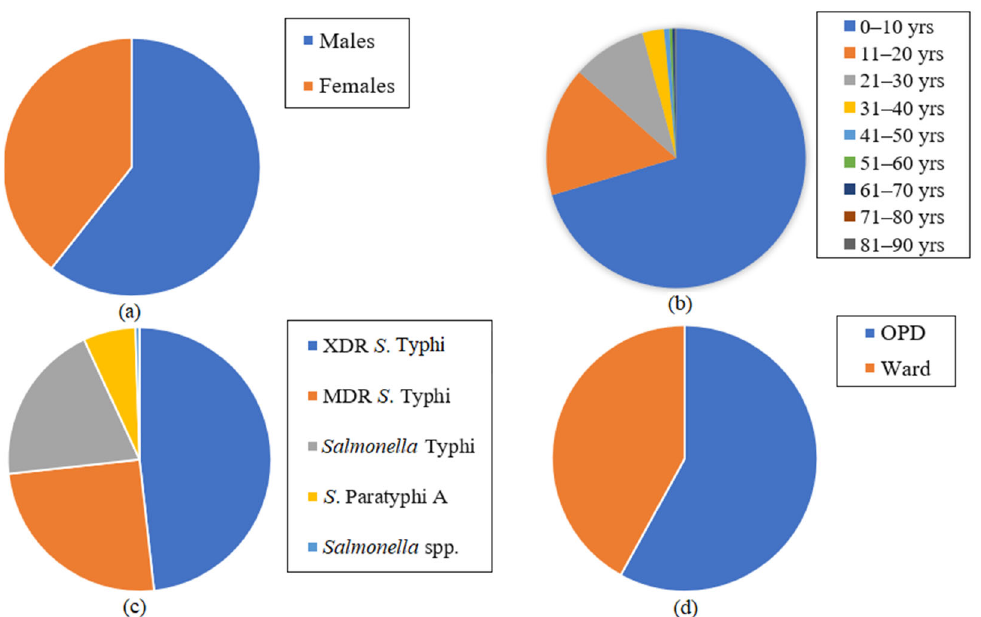
Figure 1. The distribution of typhoid fever cases according to ( a ) gender, ( b ) age, ( c ) cases in Outpatient Department (OPD) and hospital ward, and ( d ) Salmonella strains (XDR S . Typhi, MDR S . Typhi, S . Typhi, S . Paratyphi A, and Salmonella spp.) in both OPD and ward sections of the hos ‐ pital.